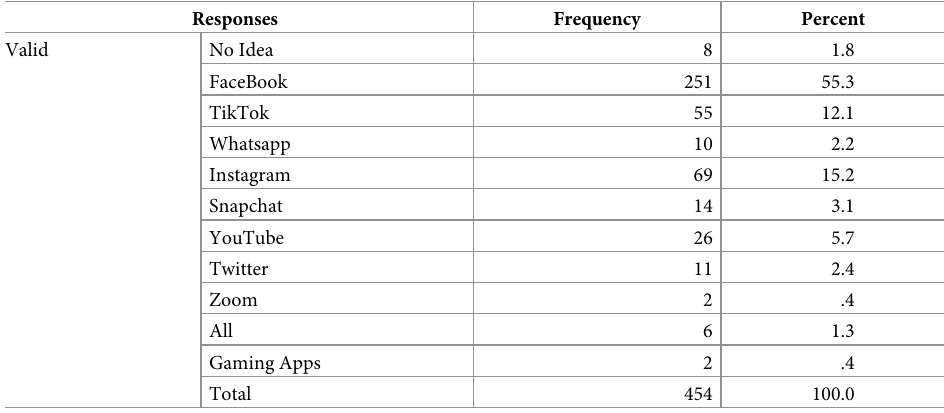
Table 5. Cyberbullying forums.